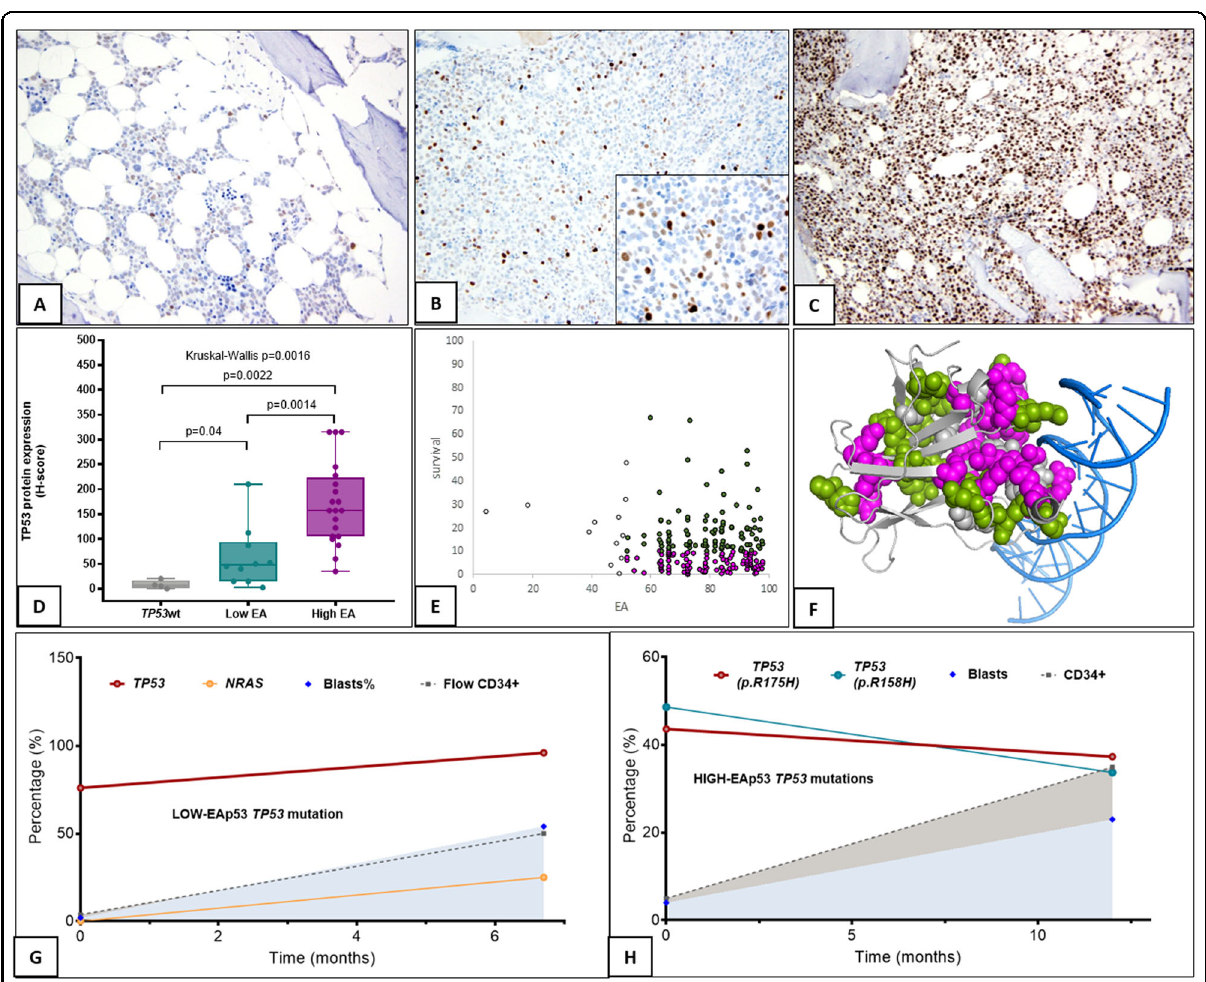
Fig. 2 EAp53 score and TP53 protein expression (A-D), TP53 protein structural analysis (E-F) and sequential NGS comparing mutational dysnamics in low-EA-MDS and high-EA-MDS. A TP53 protein expression by immunohistochemistry: immunohistochemical staining pattern for in low-EA-MDS with diploid karyotype shows weak staining in ~80% of cells ( B ) low-EA-MDS with complex karyotype shows the dual population of cells: strong positive cells in ~5% and weak positive cells in 10% of all cells; inset shows staining at ×1000 magni fi cation ( C ) IHC staining pattern in high-EA-MDS shows strong positivity in >50% of cells (high H-score). D Median H-scores of TP53 protein expression by IHC showed signi fi cant differences between TP53 wild-type MDS, low-EA-MDS, and high-EA-MDS. E Graph demonstrating the variability of overall survival of patients with the same EAp53 scores attributed to the different structural location of these mutants on the protein: survival time is plotted against the Evolutionary Action score, for 215 patients who were divided into 113 patients with poor survival (pink dots) and 102 patients with good survival (green dots) using a threshold of 10 months. F A cartoon representation of the TP53 core domain structure bound to DNA (PDB ID of 4HJE, visualized by PyMOL) with residues mutated mostly in patients with poor survival represented by pink atomic spheres, residues mutated mostly in patients with good survival represented by green atomic spheres, and residues with equal numbers of patients with poor and good survival represented by white atomic spheres. Sequential NGS analysis of G . low-EA-MDS showing persistence of TP53 mutation with additional concurrent NRAS mutation at AML transformation and ( H ) high-EA-MDS showing persistence of TP53 mutations without new mutations at AML transformation. The gray color is the area under the track of CD34 + cells over time detected by fl ow cytometry. The blue color is the area under the blast percentage tracked over time by morphologic